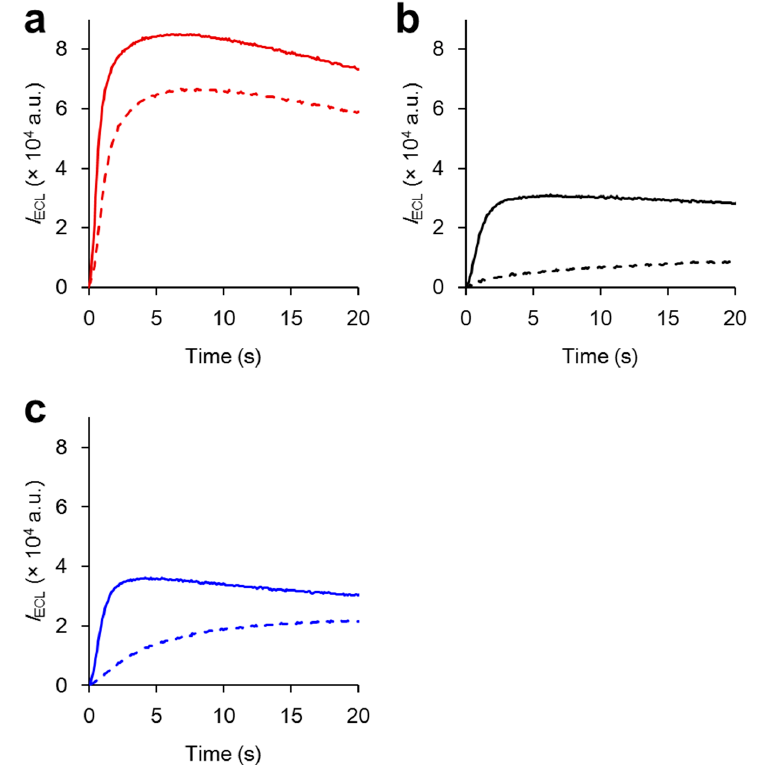
Figure 3. Time courses of ECL with ( a ) Ru-POSS, ( b ) Ru(bpy) 32+ and ( c ) Ru-Model in BE with 0.1 mM Ru(II) complexes and 100 mM TPrA in 0.20 M PBS buffer (pH 8.8) with Ar (solid line) and O 2 bubbling (dashed line) with an ITO electrode at 1.2 V vs. Ag/AgCl. The concentration of Ru-POSS was based on a Ru(II) complex unit.